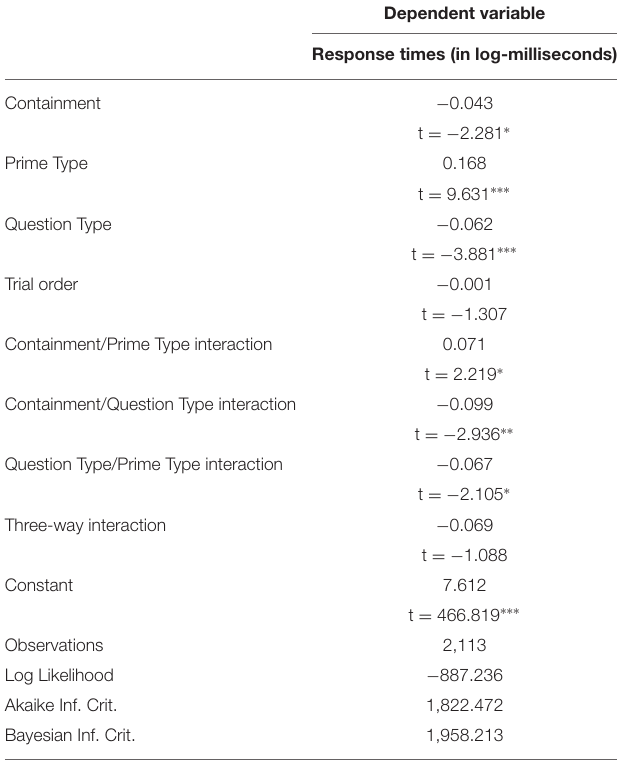
TABLE 11 | Regression analysis of response-times in Experiment